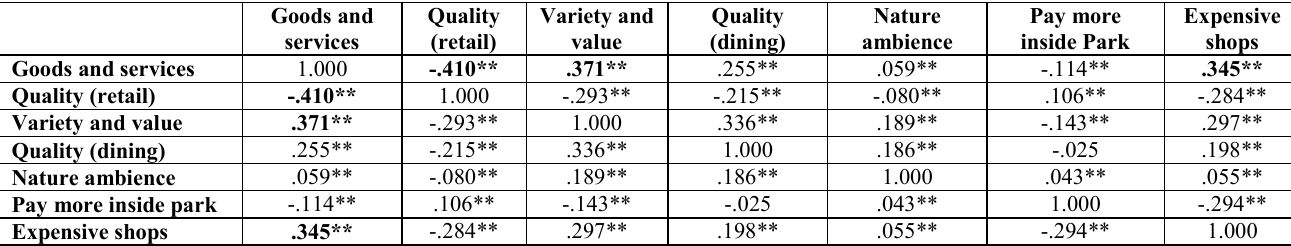
Table 4: Spearman’s rank order correlations for retail and dining experience factors